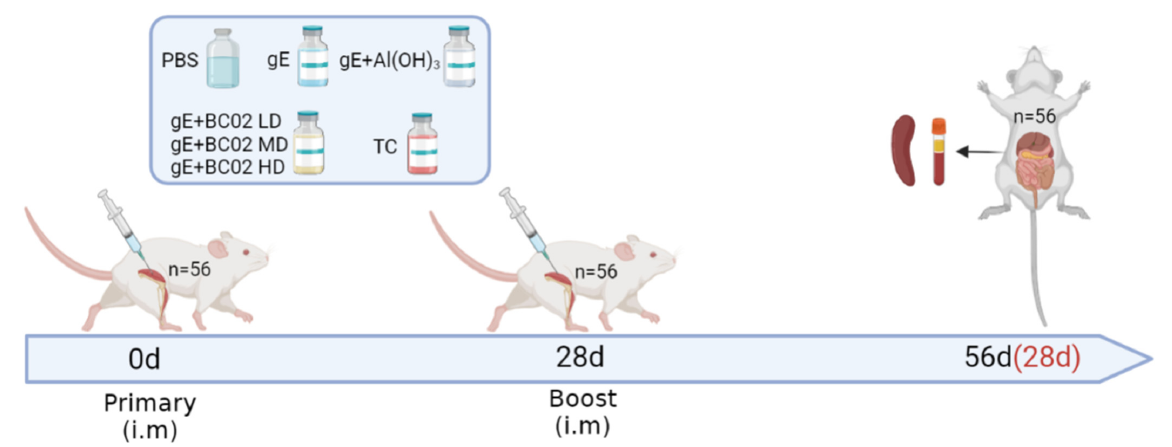
Figure 1. Mouse immunization and sampling schedule. Fifty-six mice were randomly divided into seven groups, and booster immunizations were performed at intervals of 4 weeks after the primary immunization. Mice were sacrificed at 56 days after the primary immunization (28 days after booster immunization) and peripheral blood and spleen was collected. The spleen lymphocytes were isolated for immunological detection. LD: Low dose, MD: Medium dose, HD: High dose.